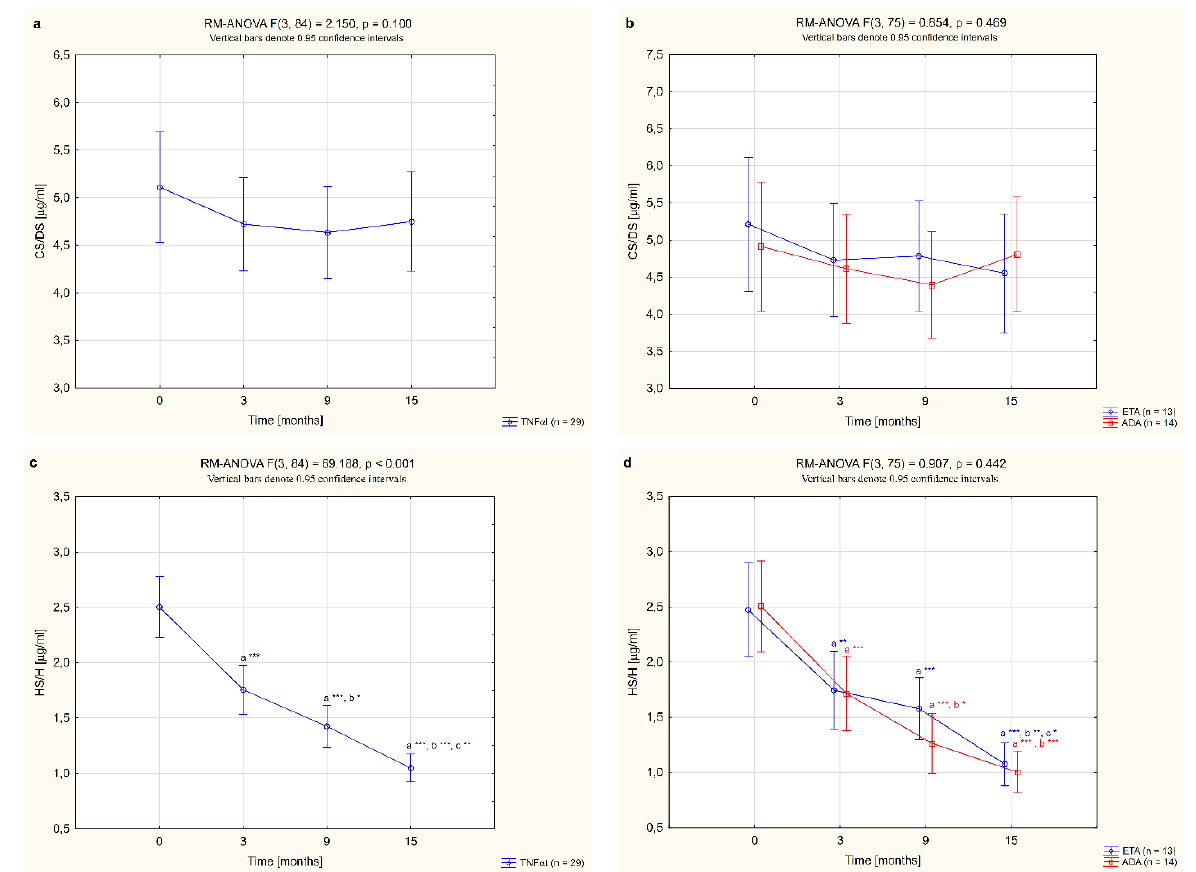
the age-matched healthy controls ( p = 0.414; Table 2).